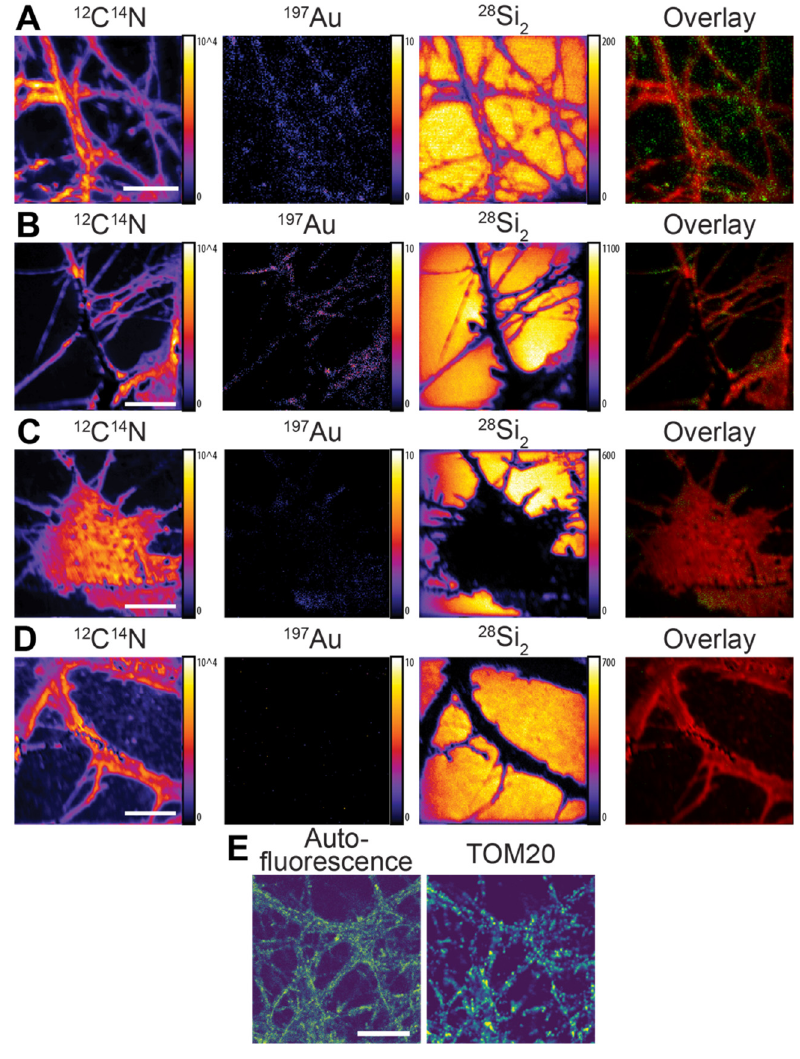
Figure 3. NanoSIMS imaging of specific proteins in hippocampal neurons via indirect immunolabeling with the Au anti-mouse secondary nanobody. ( A ) Synaptic protein Synaptotagmin 1. 128 × 128 pixels. From left to right: ion images of 12 C 14 N, 197 Au, 28 Si 2 , and overlay of 197 Au (green) and 12 C 14 N (red). ( B ) Mitochondrial marker TOM20. 256 × 256 pixels. From left to right: ion images of 12 C 14 N, 197 Au, 28 Si 2 , and overlay of 197 Au (green) and 12 C 14 N (red). ( C ) Negative control cell with Au anti-mouse secondary nanobody in the absence of primary antibody. 256 × 256 pixels. From left to right: ion images of 12 C 14 N, 197 Au, 28 Si 2 , and overlay of 197 Au (green) and 12 C 14 N (red) ( D ) Negative control cell in the absence of both primary antibody and Au anti-mouse secondary nanobody. From left to right: ion images of 12 C 14 N, 197 Au, 28 Si 2 , and overlay of 197 Au (green) and 12 C 14 N (red). Color scale of 197 Au image is scaled to the maximum intensities of respective 12 C 14 N image. ( E ) Exemplary confocal images of mitochondrial marker TOM20 in rat hippocampal neurons tagged with the anti-TOM20 primary mouse antibody. The primary antibody was revealed by STAR635P-conjugated anti-mouse secondary nanobodies ( n = 10 images). Scale bars are 10 µm.